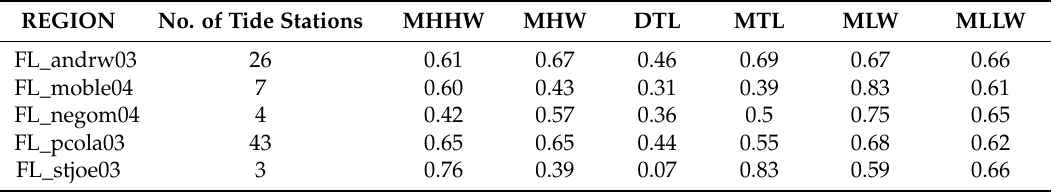
Table 4. Comparison of observations and interpolated values (Standard deviations, cm) from the marine grids for the five areas in the VDatum region.